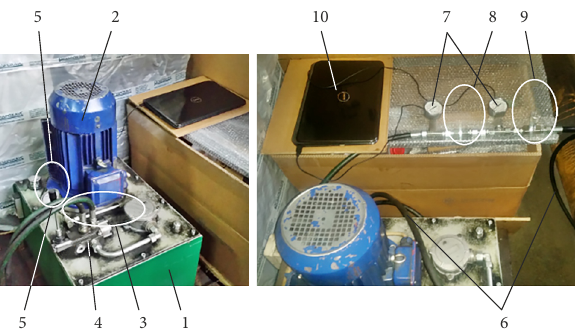
Figure 5. The experimental bench for investigating